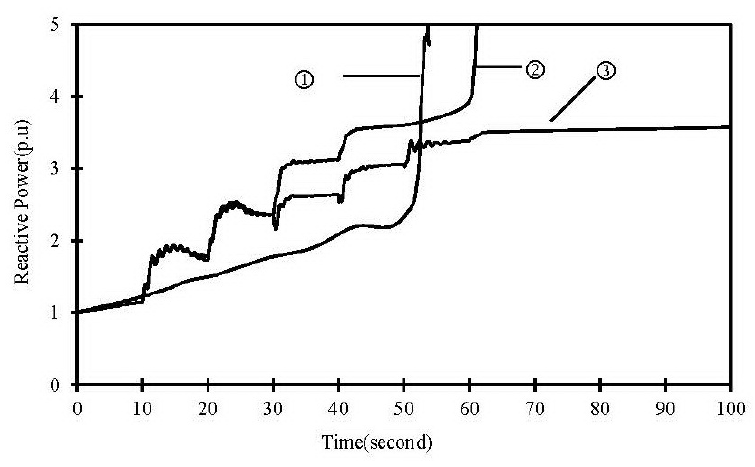
Figure 16. Output reactive power curve of bus Yimin